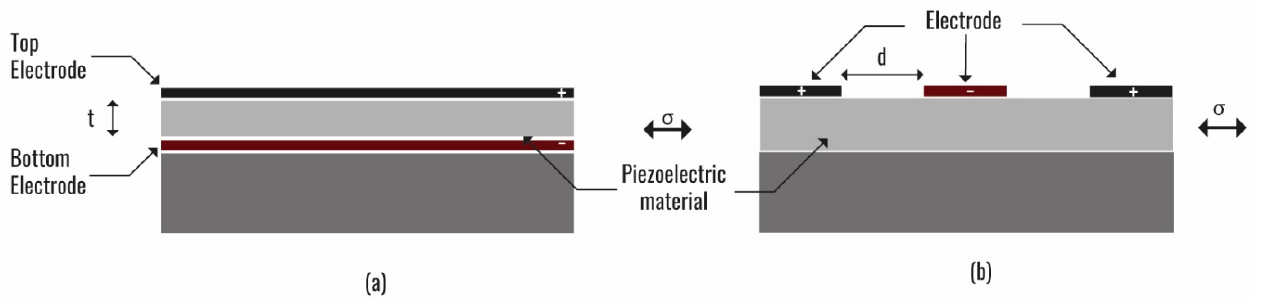
Figure 2. Piezoelectric acoustic sensor (PAS) with ( a ) D31 mode where t is the film thickness and ( b ) D33 mode where d is the electrode spacing [40].